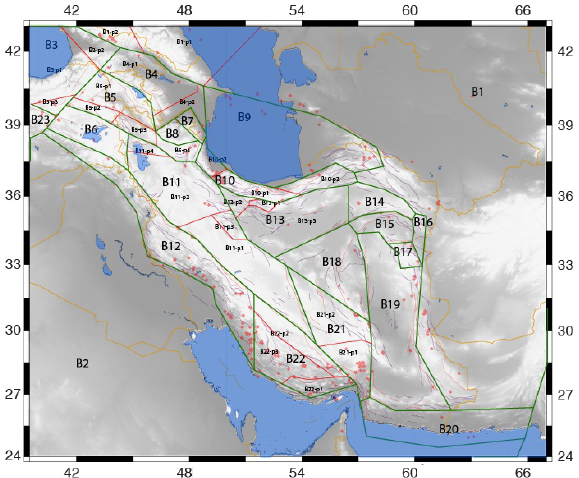
Figure 5. The new detected rigid blocks in the arrangement of the existing blocks. The Red boundaries are the new de- tected boundaries and the green lines are the initial pat- tern boundaries. The new detected blocks are named with proper suffixes and the names of old initial blocks and the new names are represented in order to clarify. The new blocks are mostly located in the north, north-east and southern initial blocks that have been divided into new